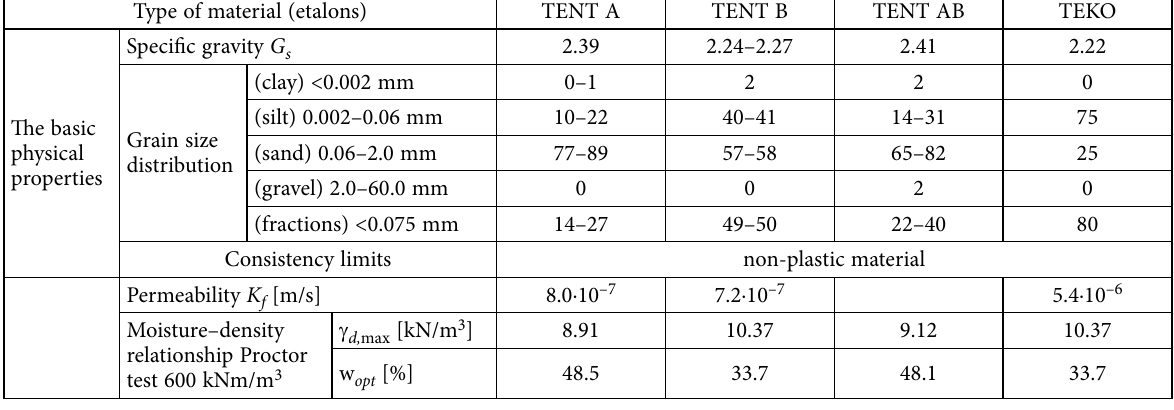
Table 6. Physical properties, permeability and moisture-density relationship of the tested materials without binders Type of material (etalons)